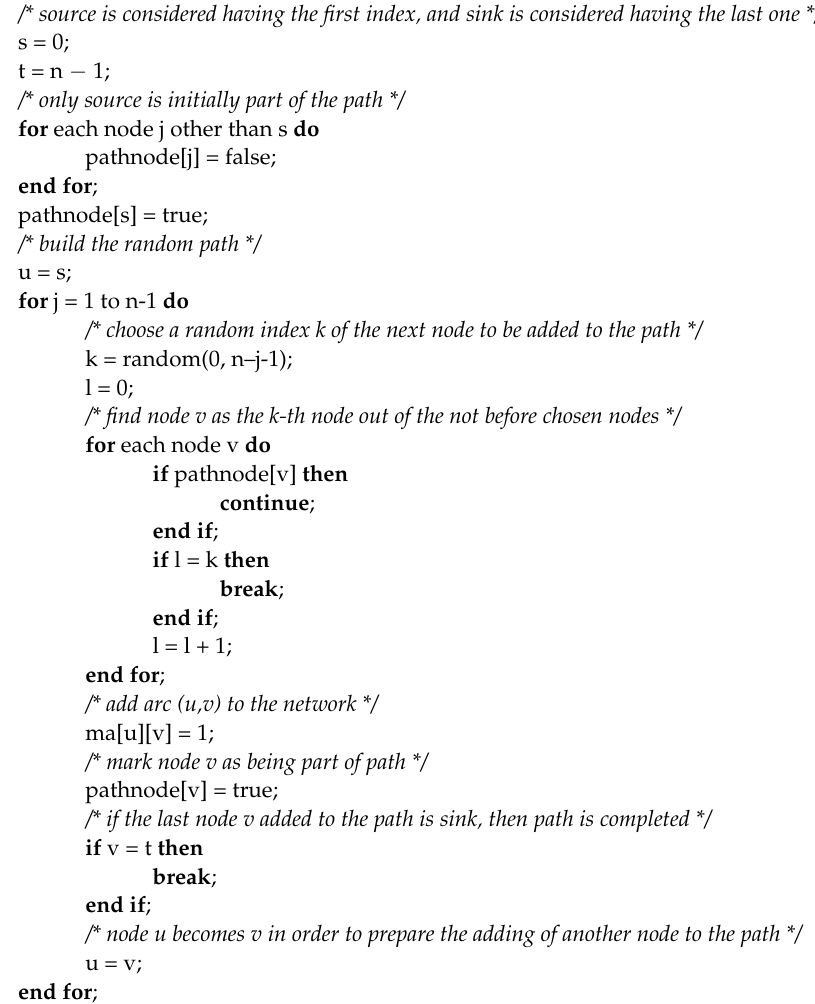
Algorithm 1. Algorithm Random s-t Directed Elementary Path v1